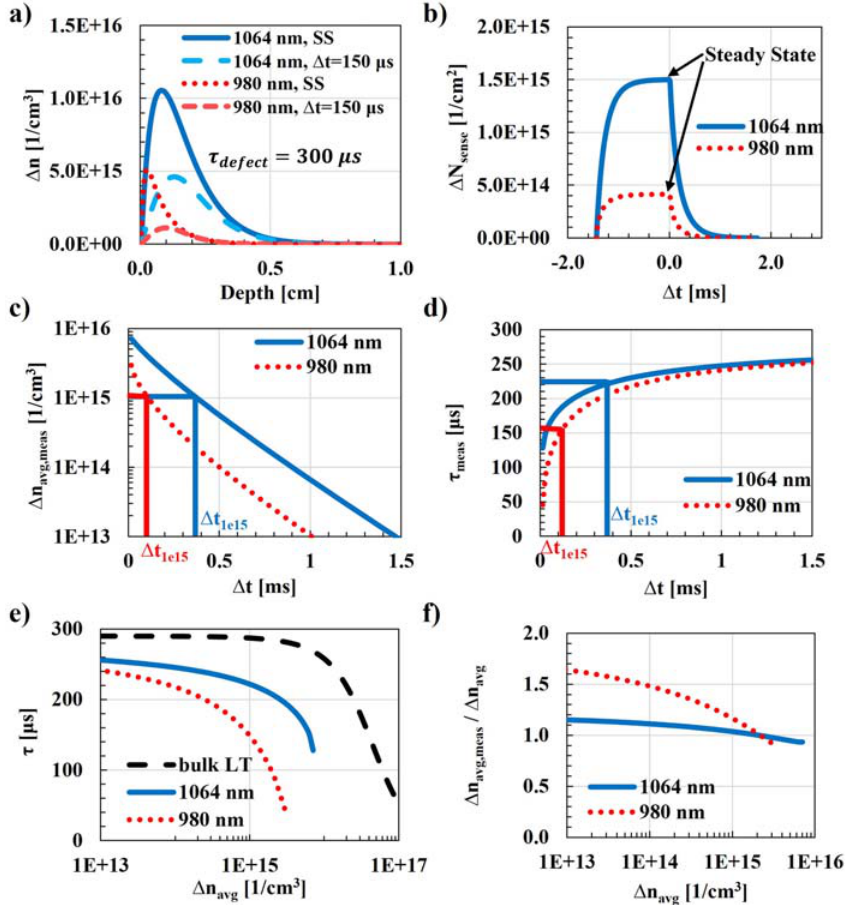
Fig. 3. Simulation of the e-PCD measurement of a gallium doped ingot with N dop = 10 16 cm (cid:1) 3 doping density and t defect = 300 m s lifetime. (a) Excess carrier depth pro fi les in steady-state conditions and D t = 150 m s time after the illumination is terminated. The depth of the maximal injection level moves towards the bulk as the near-surface carriers recombine rapidly at the surface. (b) Decay of the detected signal. Note that the steady-state condition can be always achieved by varying the pulse length. The excess carrier density (c) and the calculated lifetime (d) in the function of time elapsed. (e) The measured lifetime is more accurate with the 1064 nm laser. (f) The accuracy of the simpli fi ed injection level calculation is satisfactory using the 1064 nm laser. S front = 10 6 cm/s, F =2 (cid:3) 10 19 cm (cid:1) 2 s (cid:1) 1